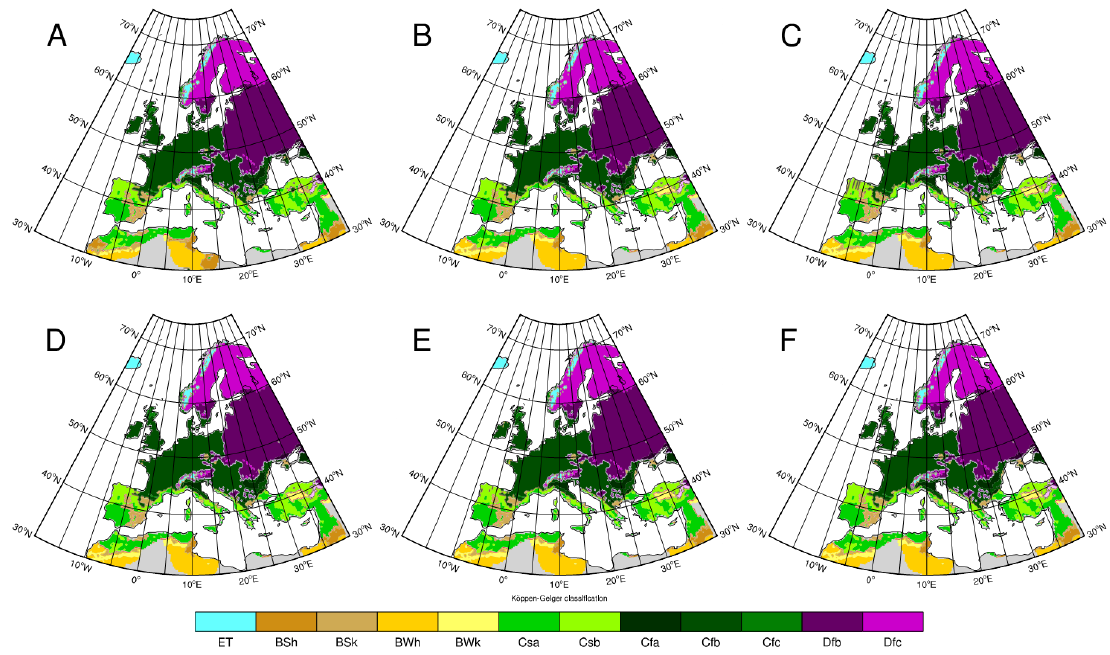
Figure 6. Simulated K-G climate classification according to E-OBS ( A ) and local intensity scaling of precipitation and variance scaling of temperature correction in ALADIN ( B ), HIRHAM ( C ), RegCM ( D ), RAMCMO2 ( E ) and RCA ( F ).